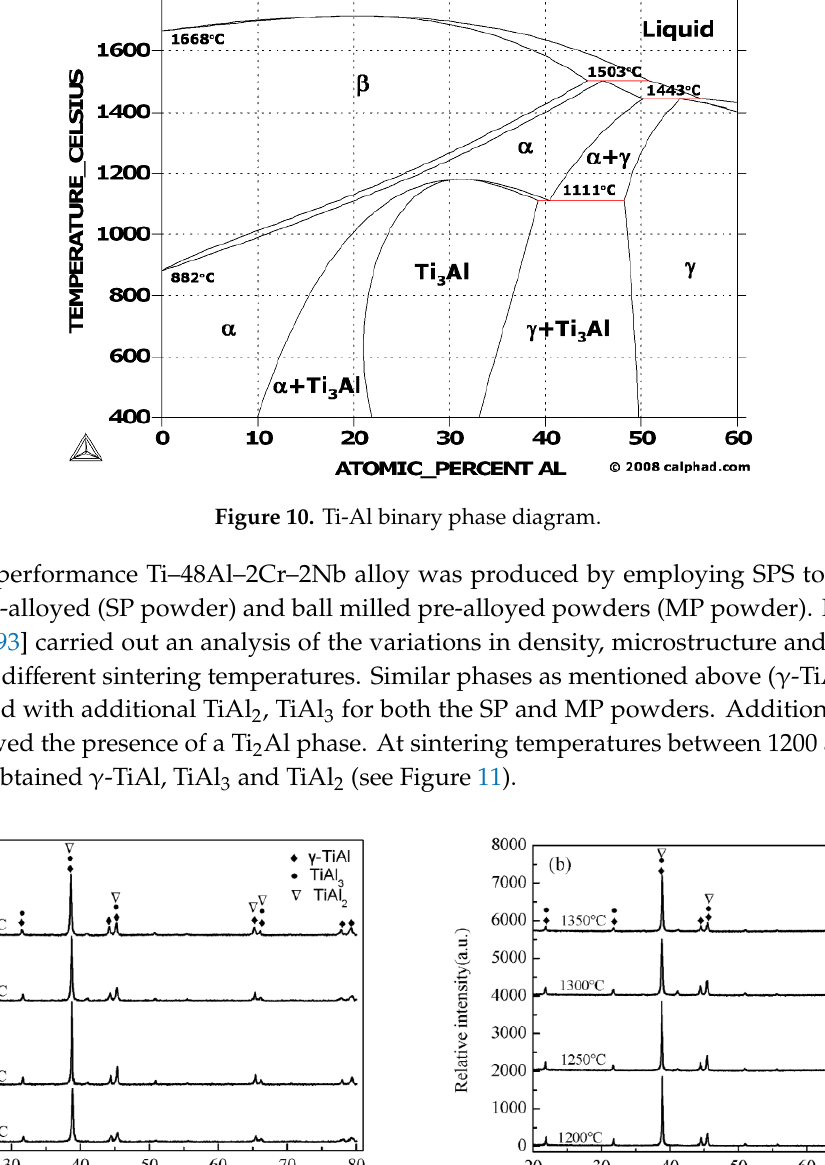
Figure 11. ( a ) XRD patterns of Ti-48Al-2Cr-8Nb alloys produced by SPS at different temperatures using spherical pre-alloyed (SP); and ( b ) milled ore-alloyed (MP) powders [93].